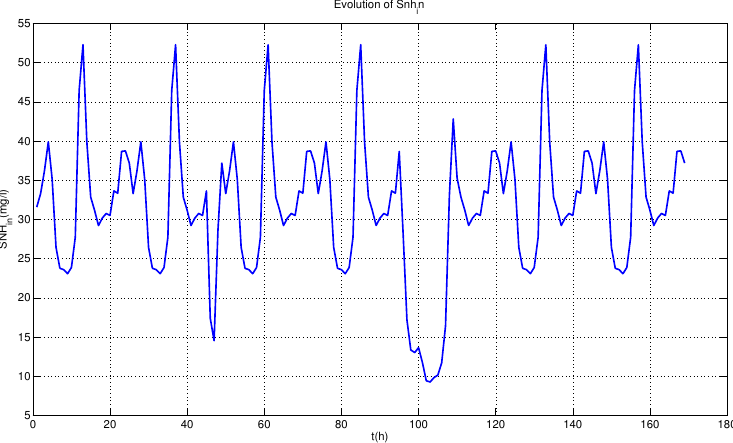
Figure 5. Concentration of ammonium compounds in the influent S NH